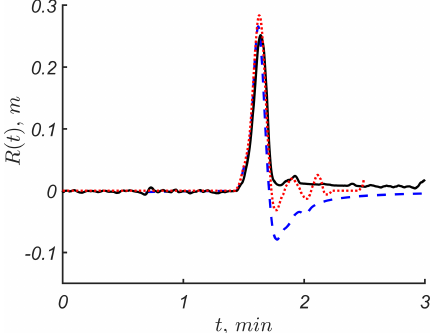
Figure 2. Water elevations along the 251m long constant depth section of the Large Wave Flume (GWK), where h 0 = 3 . 5m, A = 0 . 1m, T = 20s and tan α = 1 : 6. Results of numerical simulations are shown by the red line, and experimental data are shown by the blue line.